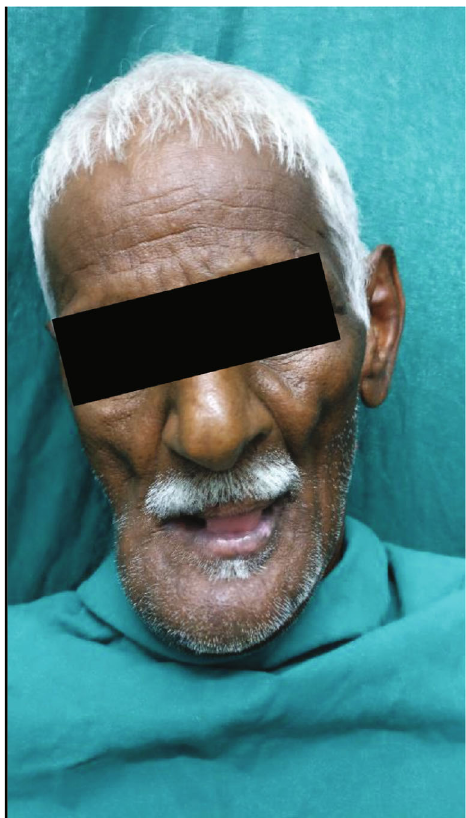
Figure 1: Preop photograph.